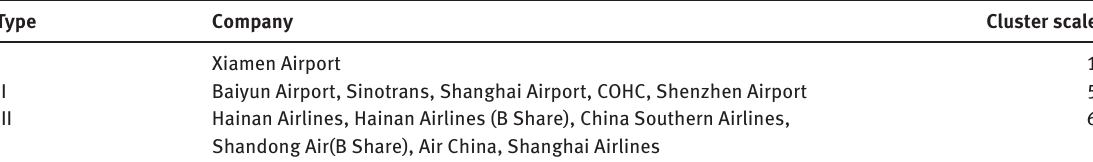
Table 5. Clustering